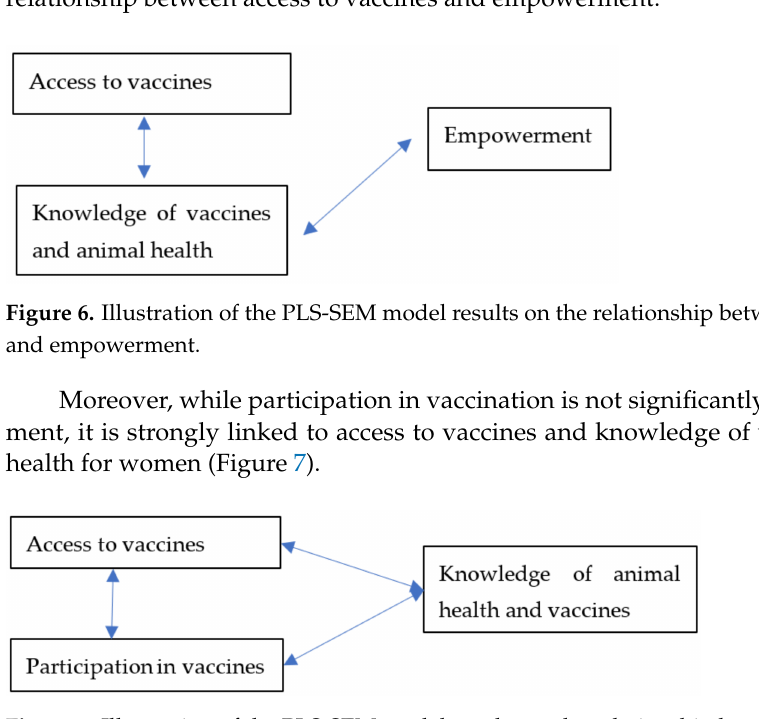
Figure 7. Illustration of the PLS-SEM model results on the relationship between vaccination facets for